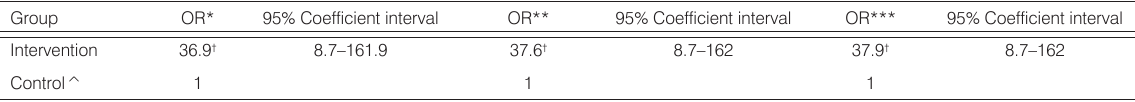
Table 7. Effects of education in lowering HbA1c by